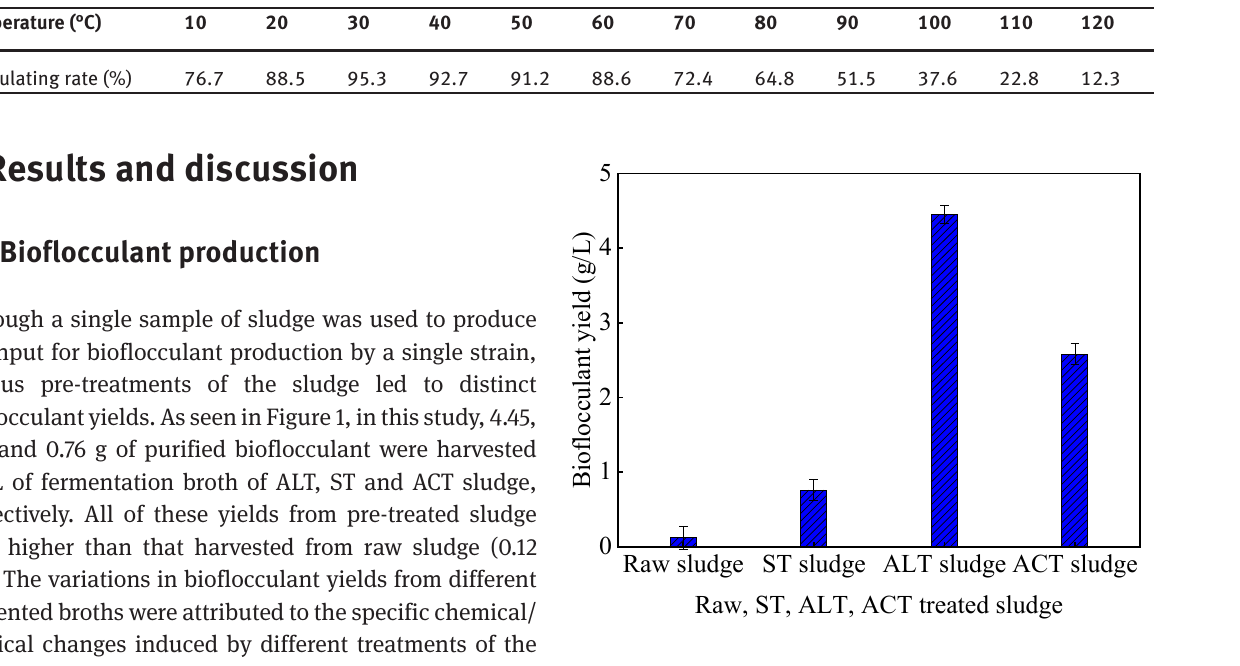
Figure 1: Effects of sludge pre-treatment on bioflocculant yield. [Error bars refer to standard deviation (3 replicates for each treatment)].